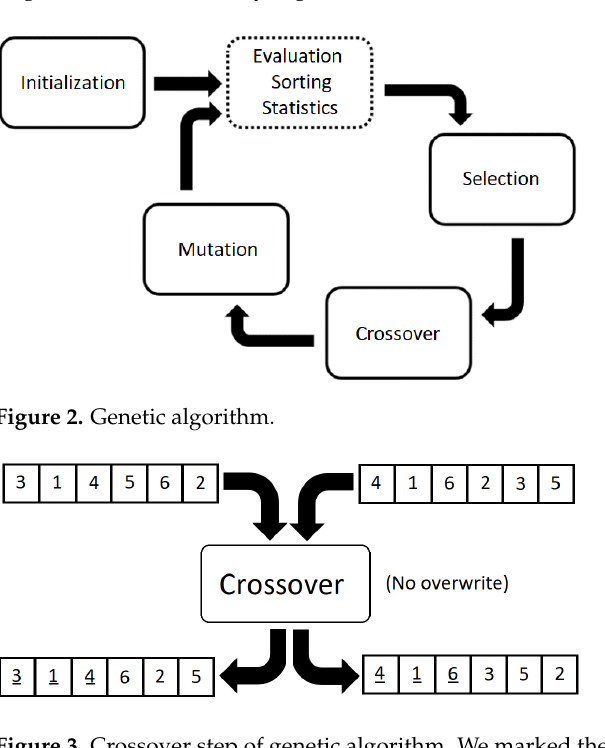
Figure 3. Crossover step of genetic algorithm. We marked the elements inherited from the primary parent by underlining the values. We only demonstrate the basic idea, there are hundreds of other known crossover